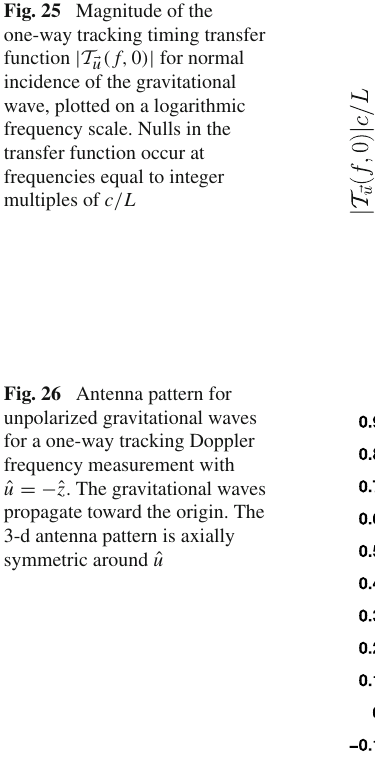
Fig. 25 Magnitude of the one-way tracking timing transfer function | T (cid:5) u ( f , 0 ) | for normal incidence of the gravitational wave, plotted on a logarithmic frequency scale. Nulls in the transfer function occur at frequencies equal to integer multiples of c / L